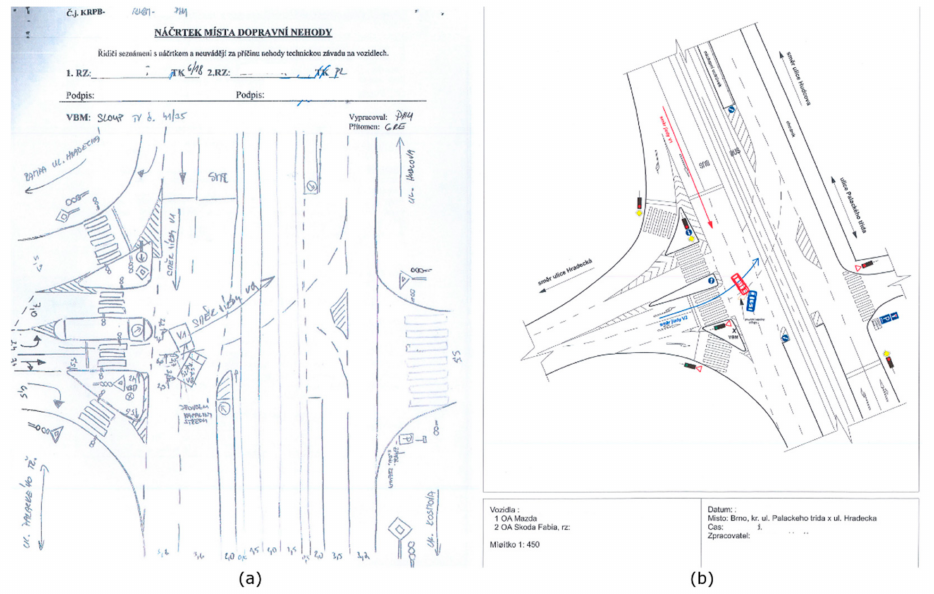
Figure 1. Sketch created on traffic accident site ( a ). Plan in the local coordinate system ( b )